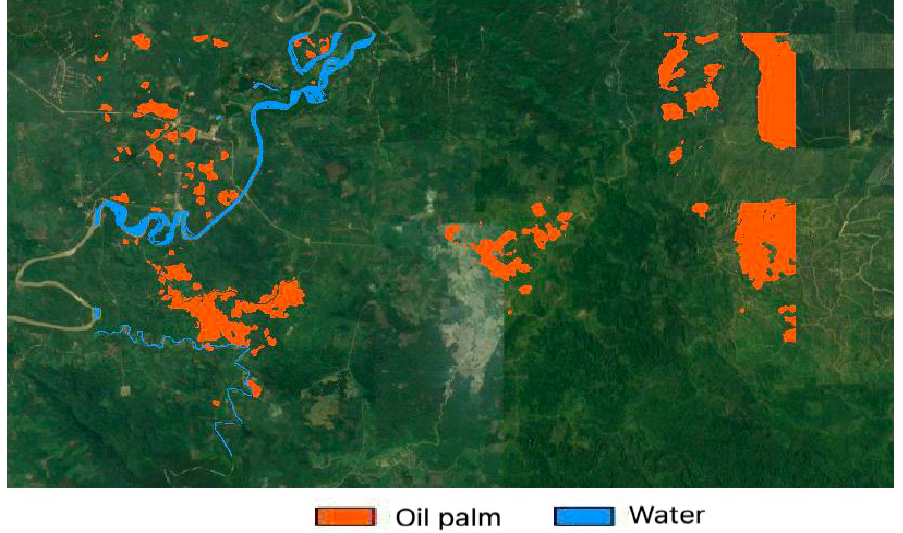
Figure 5. Map of oil palm and water grabbed from the classification